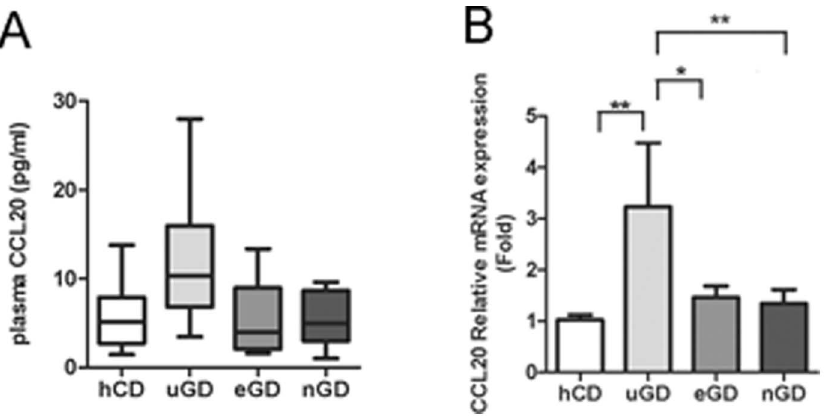
Figure 1. Plasma CCL20 and CCL20 mRNA in CD4 + T cells from GD patients and normal controls. (A) Distribution of plasma CCL20 levels in 35 healthy control donors, 50 untreated GD patients, 15 euthyroid GD patients and 12 TRAb-negative GD patients. Median values, interquartile ranges and ranges are denoted by horizontal bars, boxes and vertical bars, respectively. (B) CCL20 mRNA levels in CD4 + T cells from healthy controls, uGD, eGD and nGD patients. Data were presented as mean 6 SEM.*, P , 0.05; **, P , 0.01.